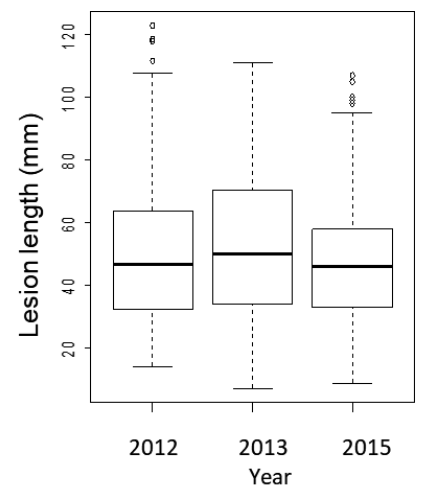
Figure 8. Boxplots of the average lesion lengths for the three trial years 2012, 2013 or 2015. The median is represented by the solid line.